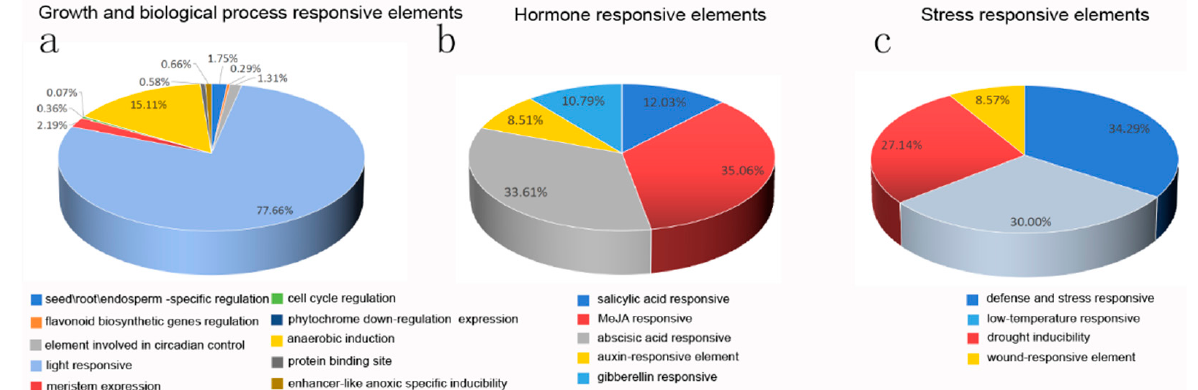
Figure 5. Percentage distribution of cis-regulator elements in the promoters of PfMADS-box genes based on the putative functions. ( a ) Growth and biological process-responsive elements. ( b ) Stress- responsive elements. ( c ) Hormone-responsive elements.